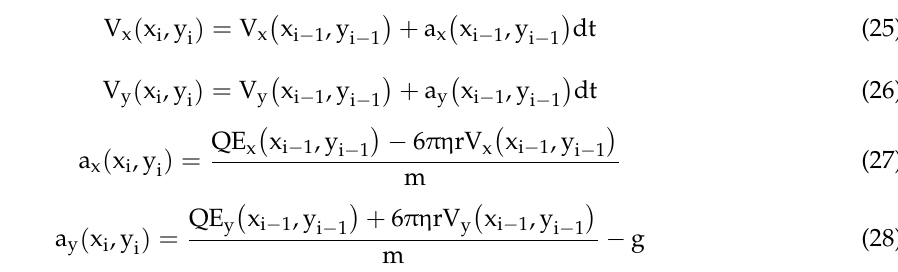
Figure 3. Automobile-shredder-residue (ASR) samples used in this study: ( a ) ASR, ( b ) glass, ( c ) copper wire.